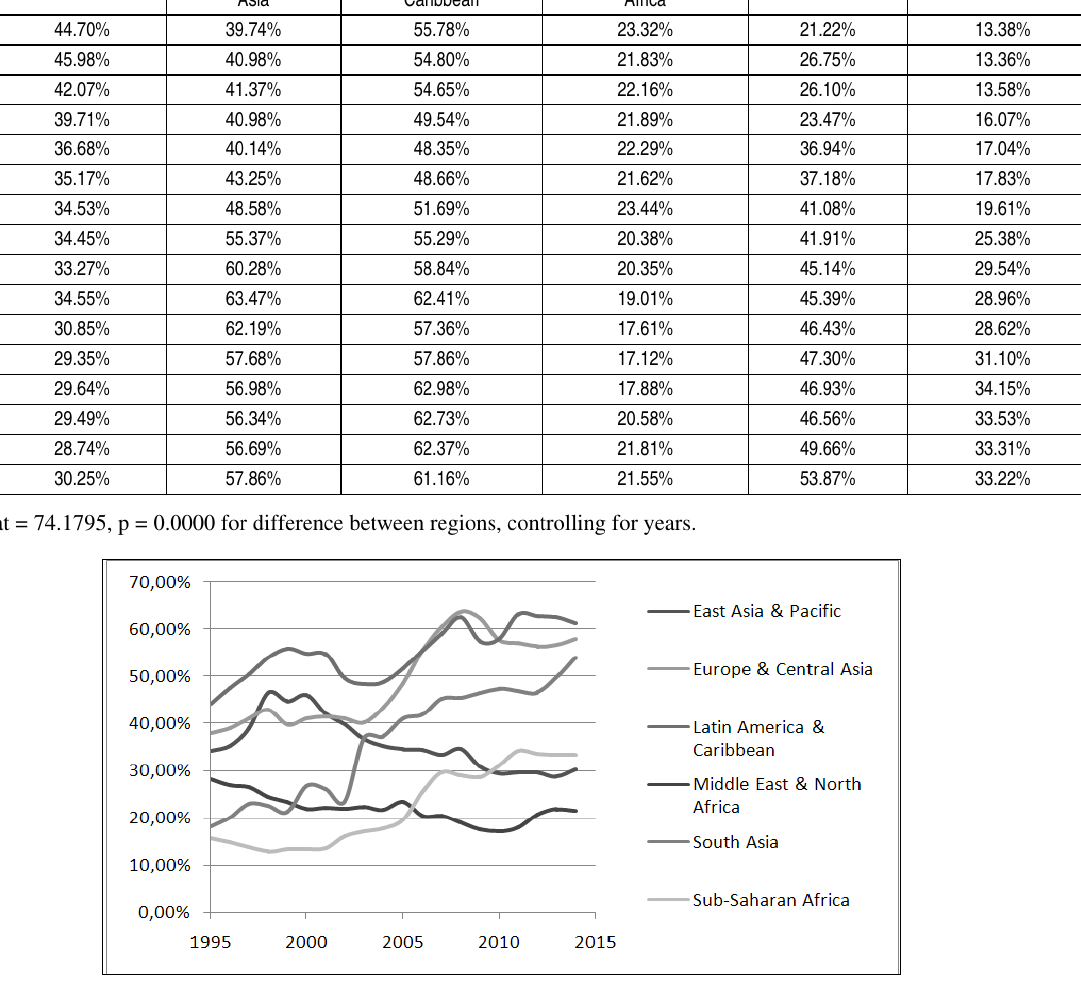
Fig. 4. Trends in VR external debt as a percentage of total gross external debt region-wise